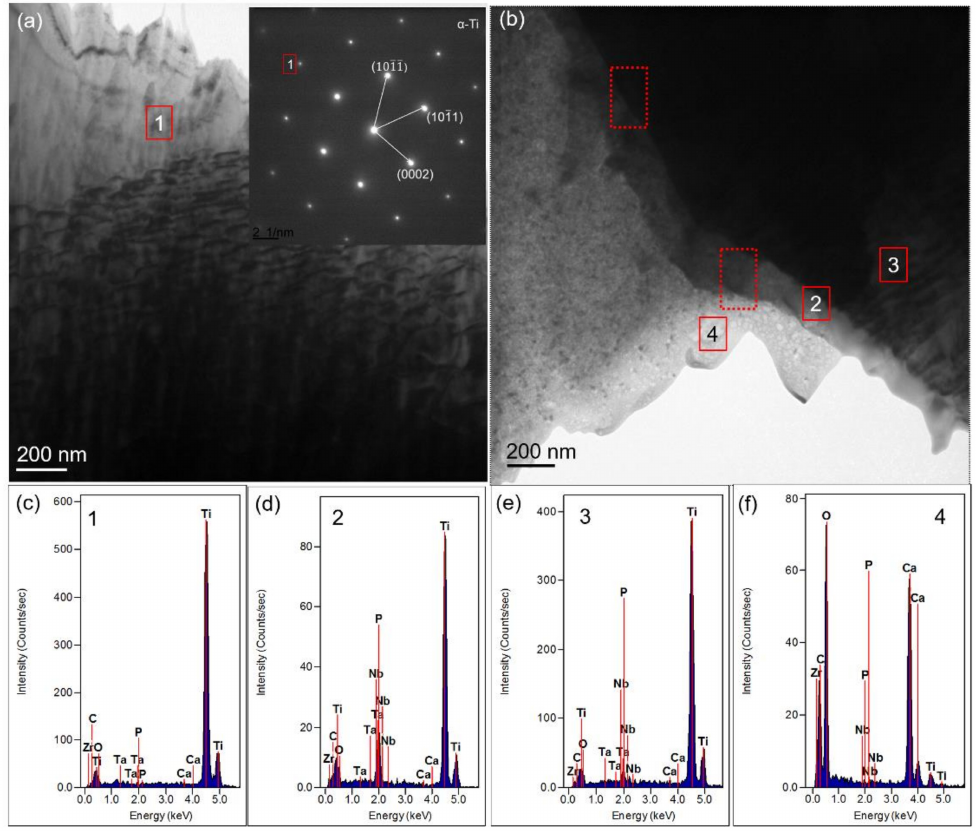
Figure 9. ( a , b ) TEM image of the 1.5-GNFs nanocomposite sintered at 1000 ◦ C in different areas. The inset shows the SAD pattern of spot 1; and ( c – f ) the corresponding EDS spectrums of spots 1–4.